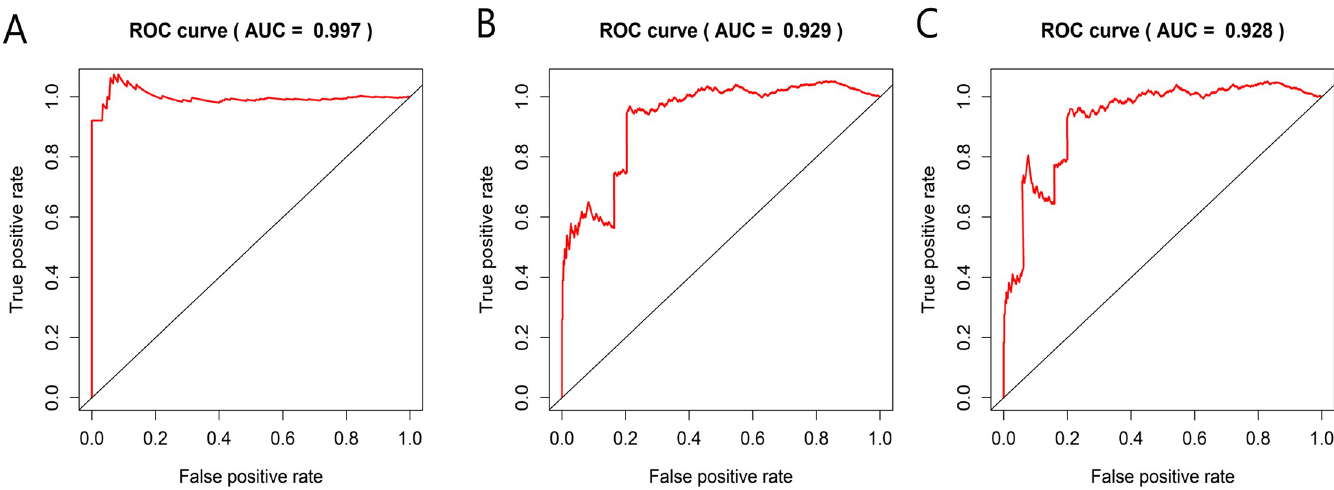
Fig 8. Prognosis prediction ability of the four-lncRNA nomogram evaluated by ROC curves and dynamic AUC lines using TCGA data. The time-dependent ROC curves at 1 (A), 3 (B) and 5 (C) years during the follow-up period, together with dynamic AUC lines were drawn for the cases.